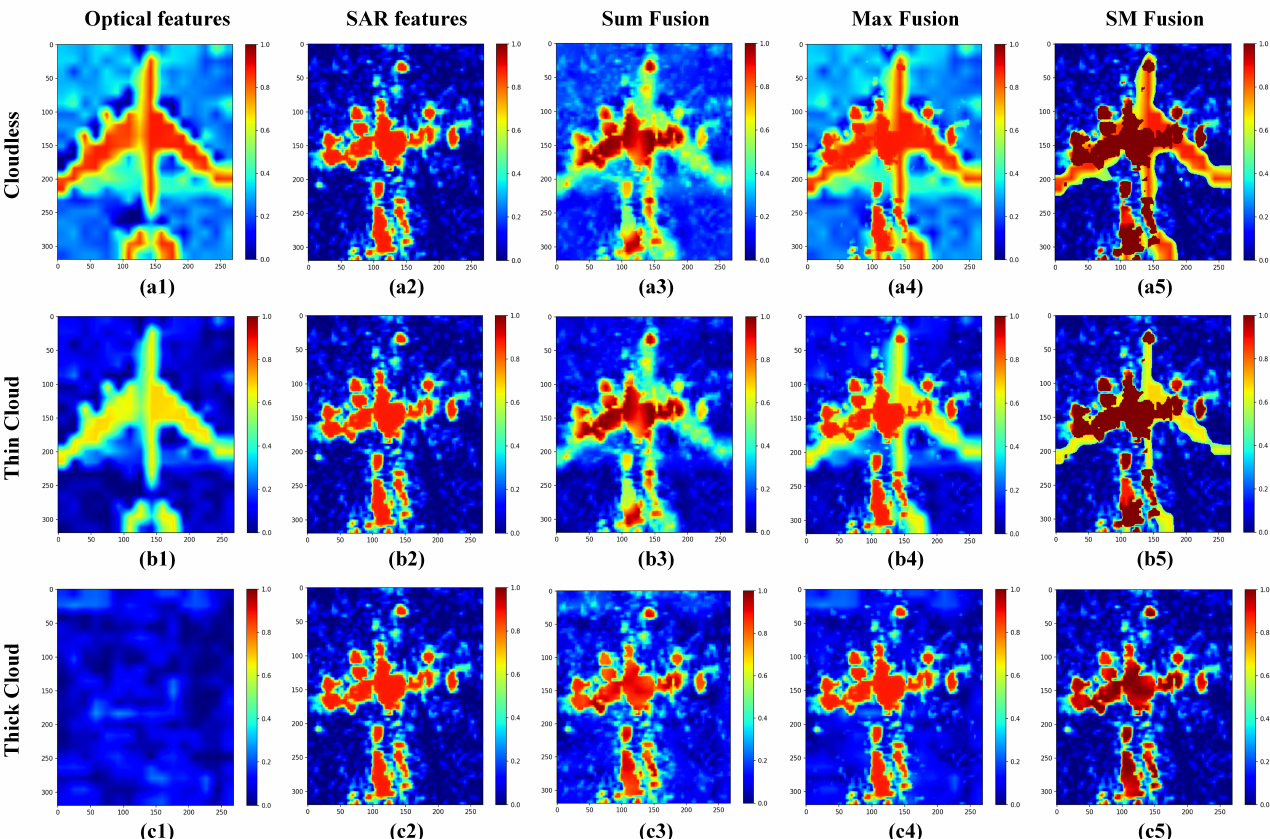
Figure 5. The comparison of different feature fusion rules. ( a1 – c5 ) The thickness of cloud v.s.